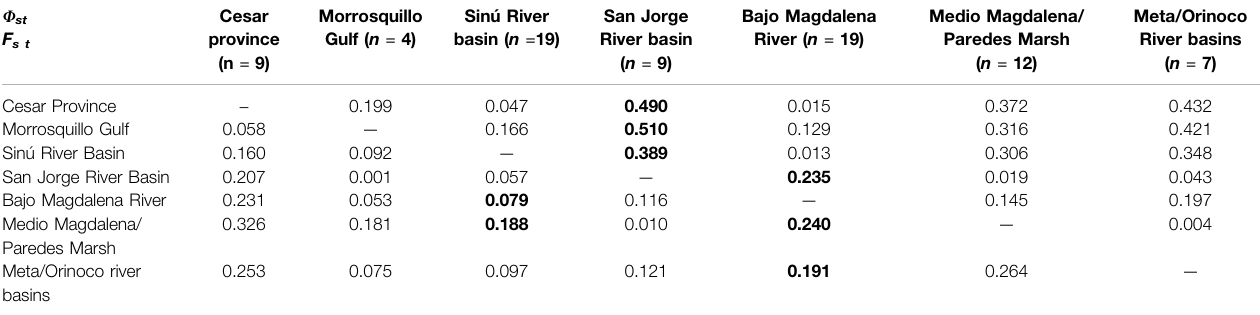
TABLE 1 | Pairwise Fst (below diagonal) and Φ st (above diagonal) values for the mitochondrial control region (410 bp) among 7 T. manatus Colombian geographic locations. Three locations (Santa Marta, Canal del Dique and Urabá Gulf) were excluded from the analysis because of their small sample size. Φ st F s